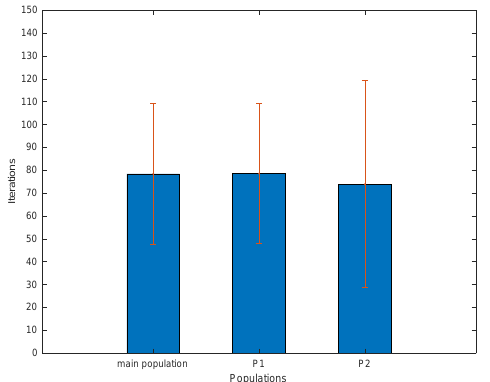
Figure 17: The figure displays the mean of the minimums of iteration of matching to find the target object for the robot population over the 18 test images (the lowest being the best).